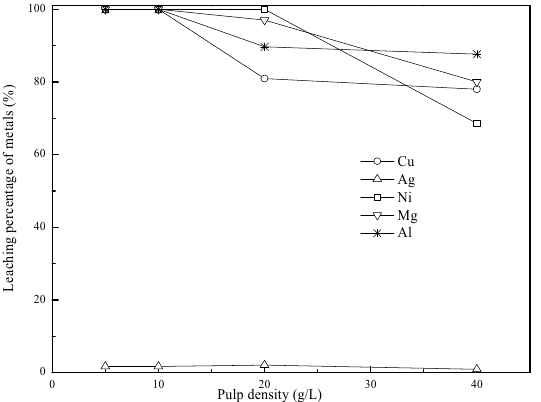
Figure 5. The effect of pulp density on the leaching of metals from industrial dust.